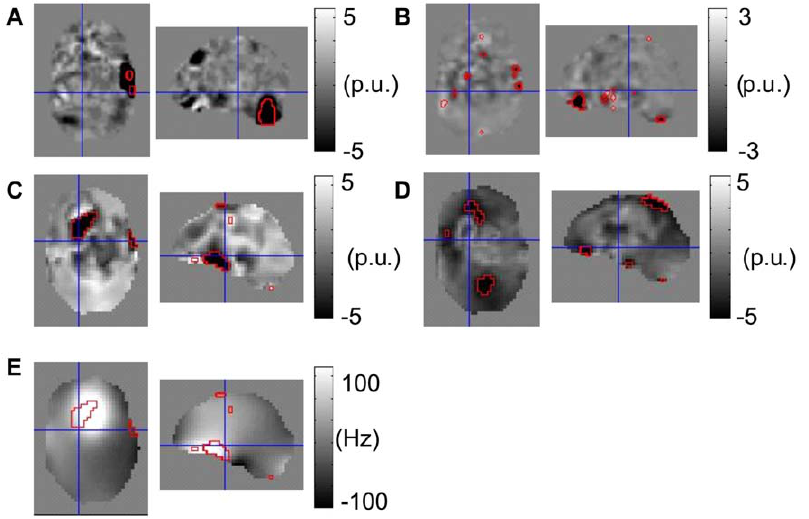
Figure 3. Improvements due to increase of the dynamic range of the method and off-resonance minimization. Changes in non- linearity (a) and instability (b) of the B 1 + maps following an increase of the maximum RF nominal value to 310 u . Change in non-linearity (c) and instability (d) of the B 1 + maps after off-resonance minimization. Regions showing significant changes in non-linearity and instability are marked by red contour lines. B 0 map acquired on the subject shown in c and d (e). The red contour lines in figure e show that off-resonance minimization improved the linearity of the method in areas with high B 0 offsets.